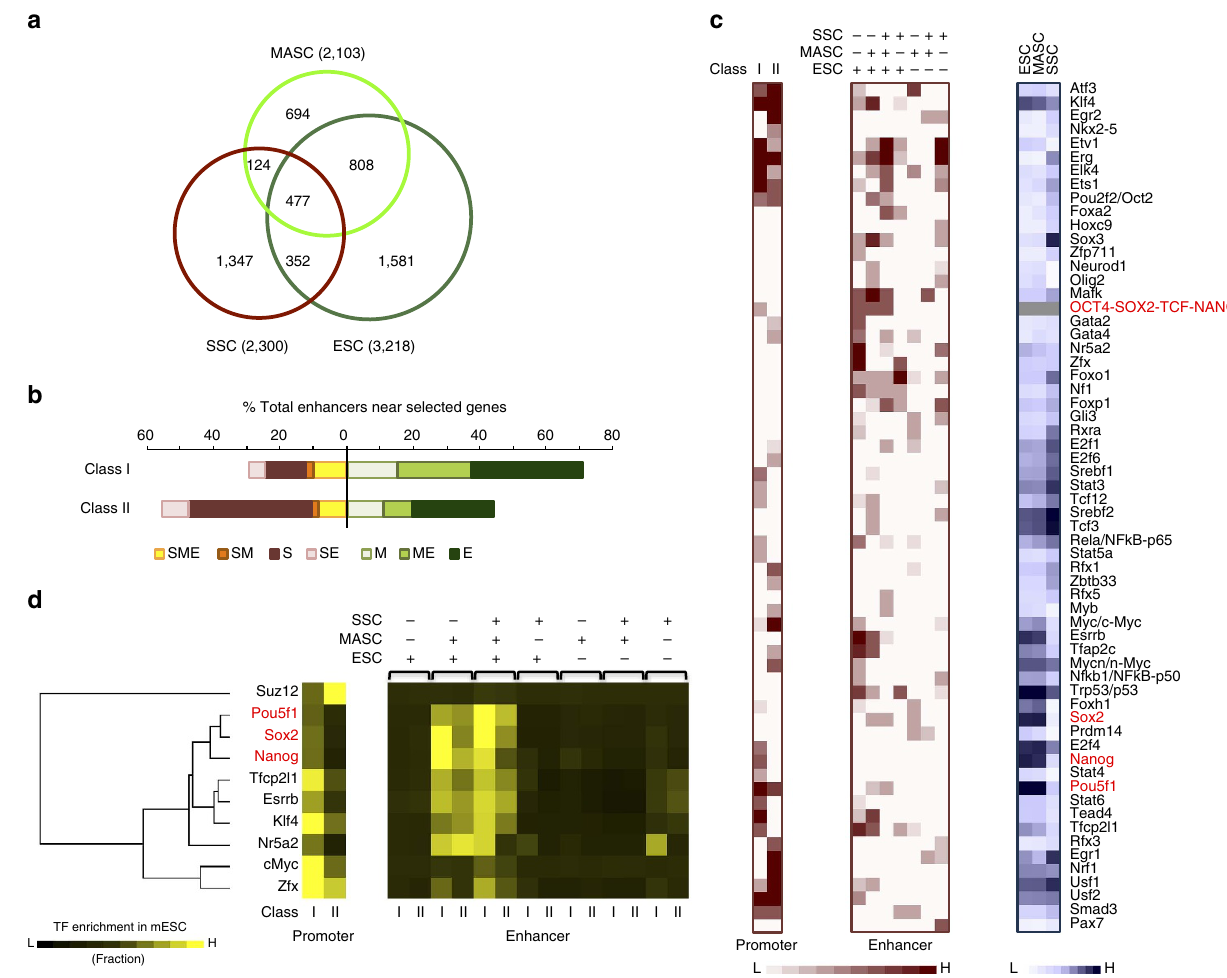
Figure 5 | Transcriptional regulators potentially involved in chromatin state changes at promoters and enhancers. ( a ) Overlap of active enhancers in SSCs, MASCs, and ESCs. Number, number of enhancers in each subset. ( b ) Percentage of enhancers near Class I and II genes. S, enhancers active only in SSCs; SM, enhancers active in SSCs and MASCs; SE, enhancers active in SSCs and ESCs; SME, enhancers active in SSCs, MASCs, and ESCs; E, enhancers active only in ESCs; ME, enhancers active in MASCs and ESCs; M, enhancers active only in MASCs. ( c ) Enrichment of transcription factor binding motifs for promoters of expression class I and II (left) and enhancers active ( þ ) or silent ( (cid:2) ) in different cell types (middle). Each row represents a motif, and the expression of the corresponding transcriptional regulator is shown in the same row in the heatmap (right). Core pluripotency transcription factors are highlighted in red. Red and white in the heatmap indicate relative over- and under-representation of motif enrichment, respectively. Blue and white indicate relative high and low gene expression, respectively. ( d ) Enrichment of transcription factors at promoters and associated enhancers in ESCs. Promoters are grouped by expression class as in Fig. 3. Enhancers are grouped by activation ( þ ) or silence ( (cid:2) ) in different cell types (top) and expression class of associated promoters (bottom). Core pluripotency transcription factors are highlighted in